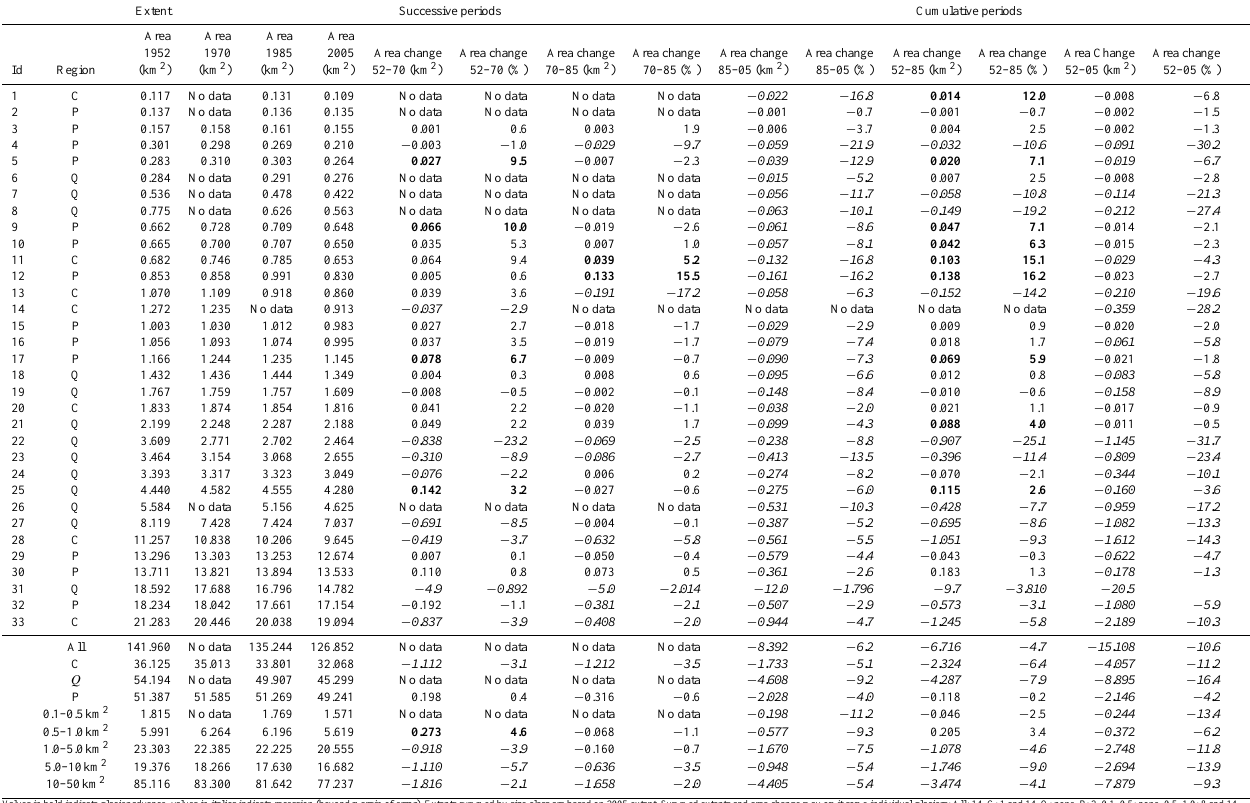
Table 3. Glacier extent and area change data for glaciers and summed by subregion and size class. Extent Successiveperiods Cumulativeperiods Area Area Area Area 1952